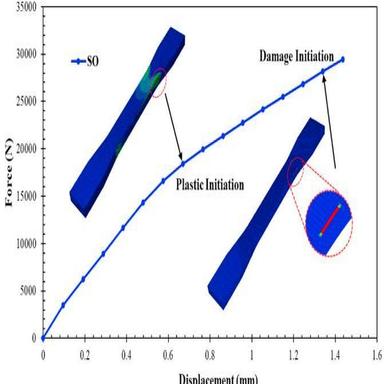
Location of plastic and damage initiation during loading (SO: Self-OPTIM).